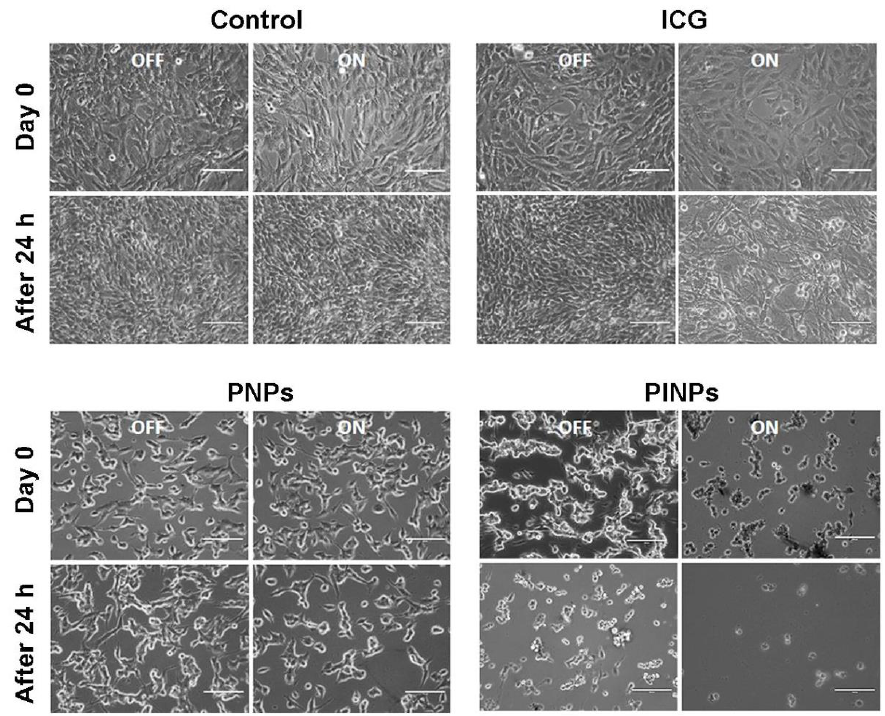
Figure 5. Brightfield images showing the collaborative chemo-PTT/PDT toxicity of PINPs exhibited in C6 cells. Scale bar: 100 µm.